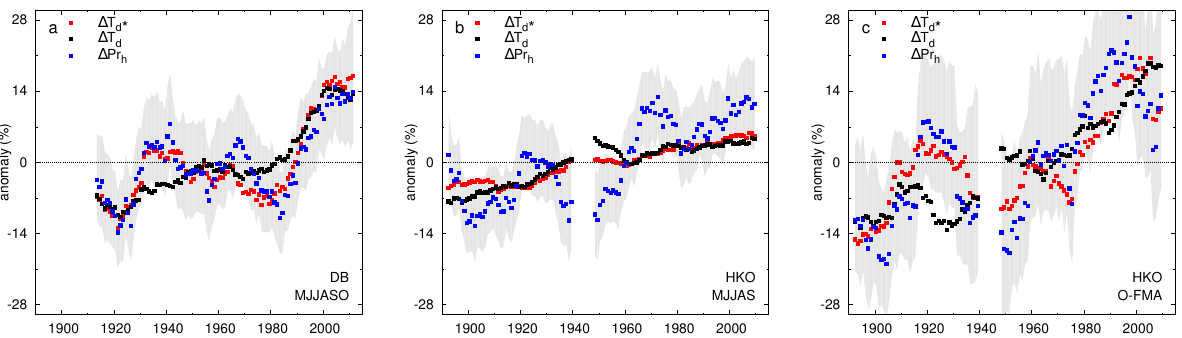
Fig. 4. Variations in hourly precipitation extremes ( 1 Pr h , that is, average over 95th, 99th, 99.5th percentiles) (blue dots)) compared to changes in dew point temperature for heavy precipitation days (with hourly precipitation exceeding the 90th percentile) (red dots) and all days (black dots). Anomalies in dew point temperature are multiplied by 14% per degree in order to compare the time variations in dew point temperature with those in precipitation intensity. Grey bands are 98% error estimates of 1 Pr h .